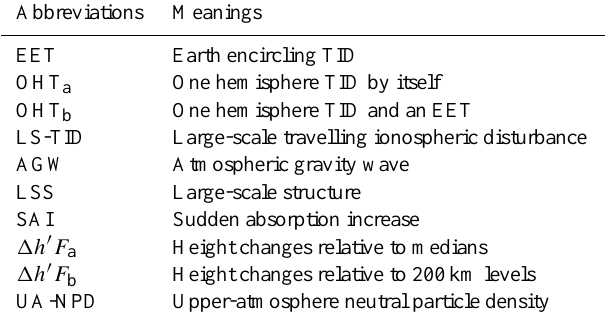
Table 2. Acronyms.